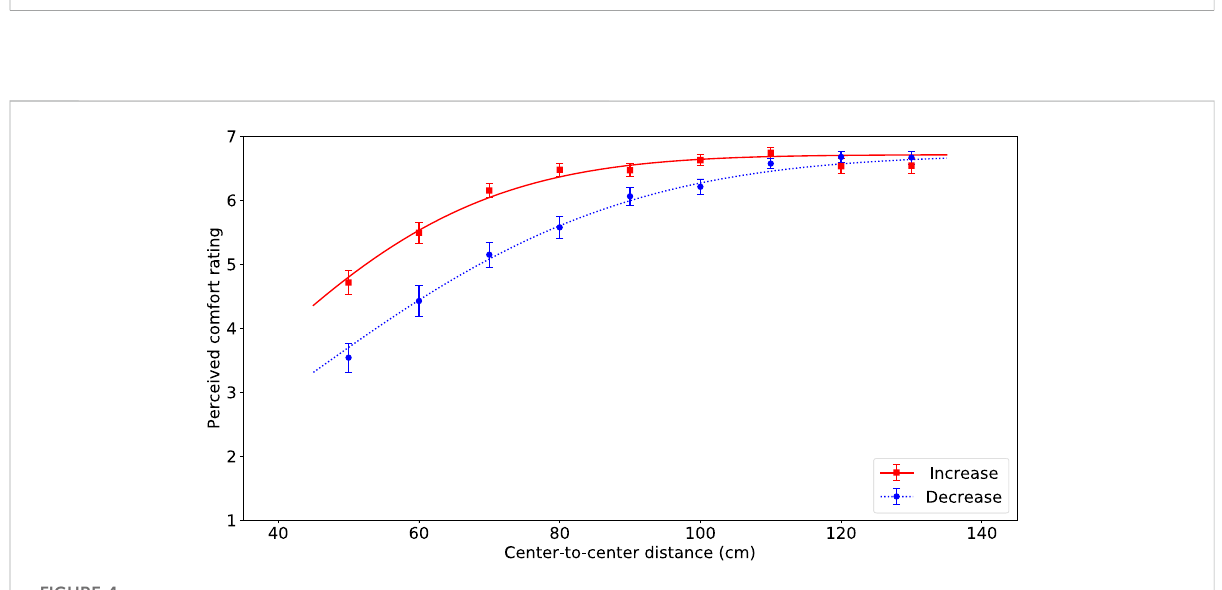
FIGURE 4 Visualization of the average comfort level per passing distance for the passing distances of the robot increasing (red squares) and decreasing (bluecircles)oftheparticipant. TheerrorbarsrepresentStandardError.Thelinesindicatethebest fi ttinginvertedGaussian,solidredlineforincrease and dashed blue line for